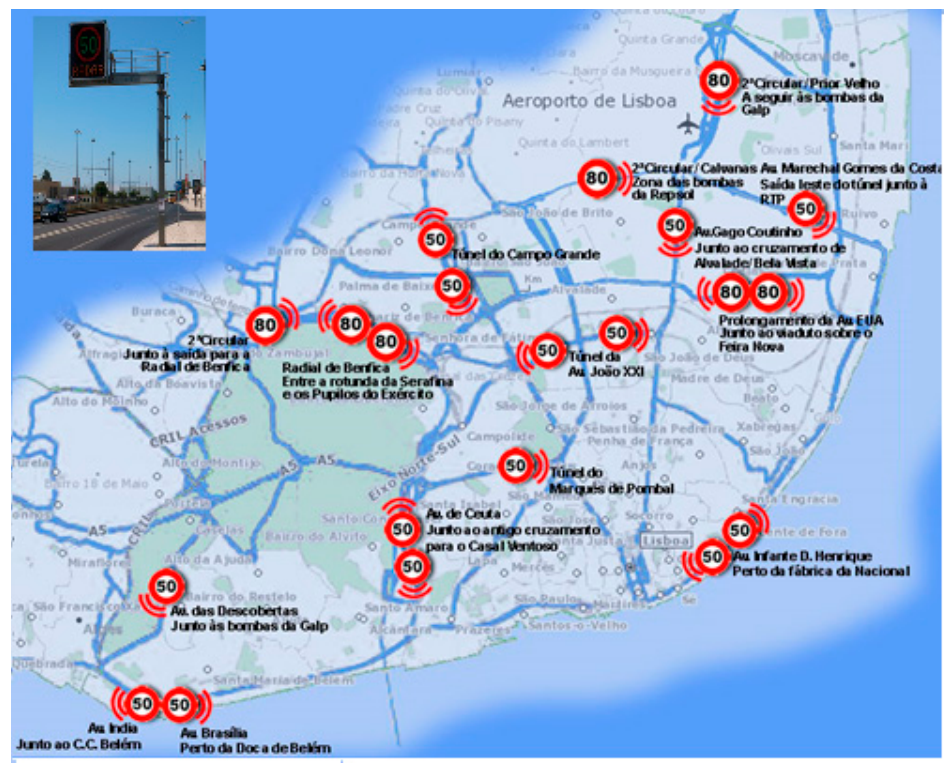
Figure 2. Speed control system locations in Lisbon and example of a speed warning panel (Av. da Índia). Crashes were considered when they occurred on the same road and the direction of travel was towards the location of the speed control